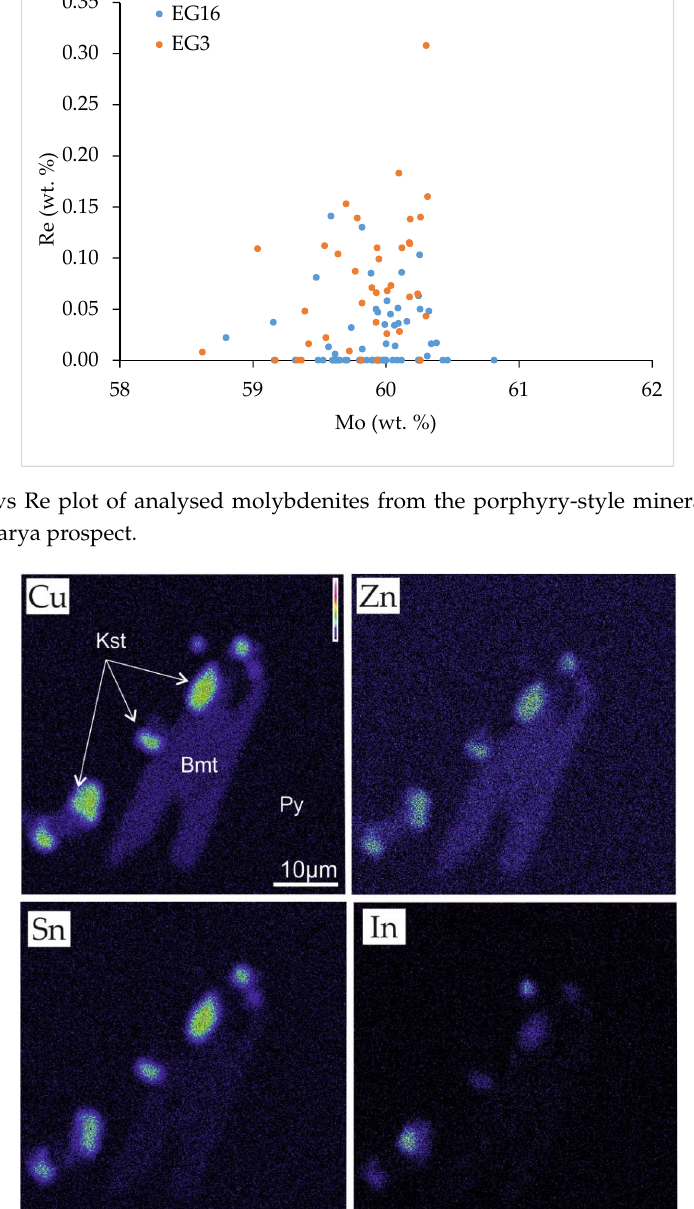
Figure 8. X-ray element mapping demonstrating distribution of Cu, Zn, Sn and In in the kesterite crystal shown in Figure 6b.